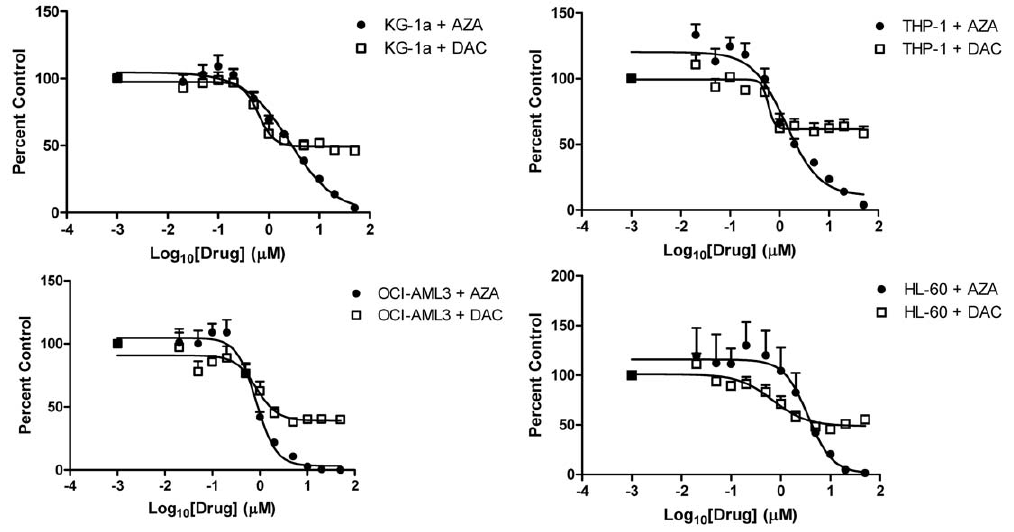
Figure 1. AZA and DAC differentially affect cell viability in AML cell lines. Cell viability of AML cell lines, KG-1a, THP-1, OCI-AML3, and HL-60, N ) or DAC ( % ) (0–50 m M) using the CellTiter-Glo assay. Standard deviation was determined from was assessed after 72 hours of treatment with AZA ( 2 or 3 independent experiments, including triplicate wells per experiment. AML = acute myeloid leukemia; AZA = azacitidine; DAC = decitabine.